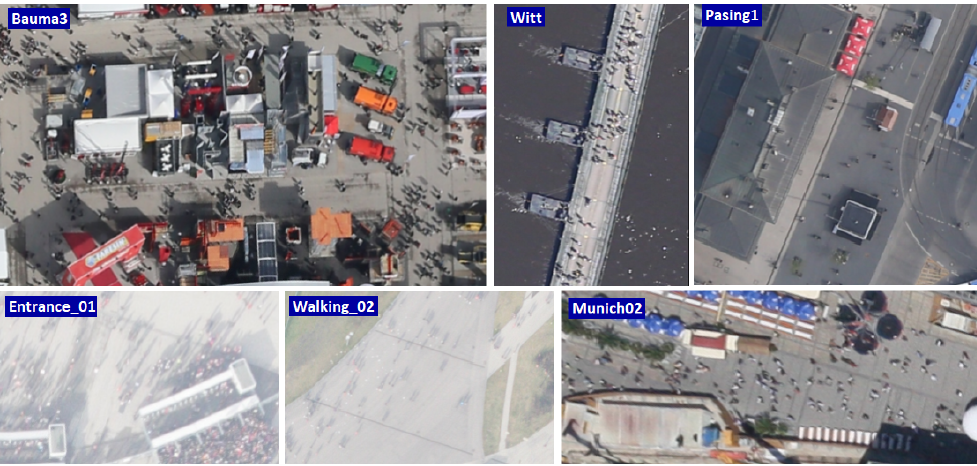
Figure 4. Sample images from the AerialMPT and KIT AIS datasets. “Bauma3”, “Witt”, “Pasing1” are from AerialMPT. “Entrance_01”, “Walking_02”, and “Munich02” are from KIT AIS.